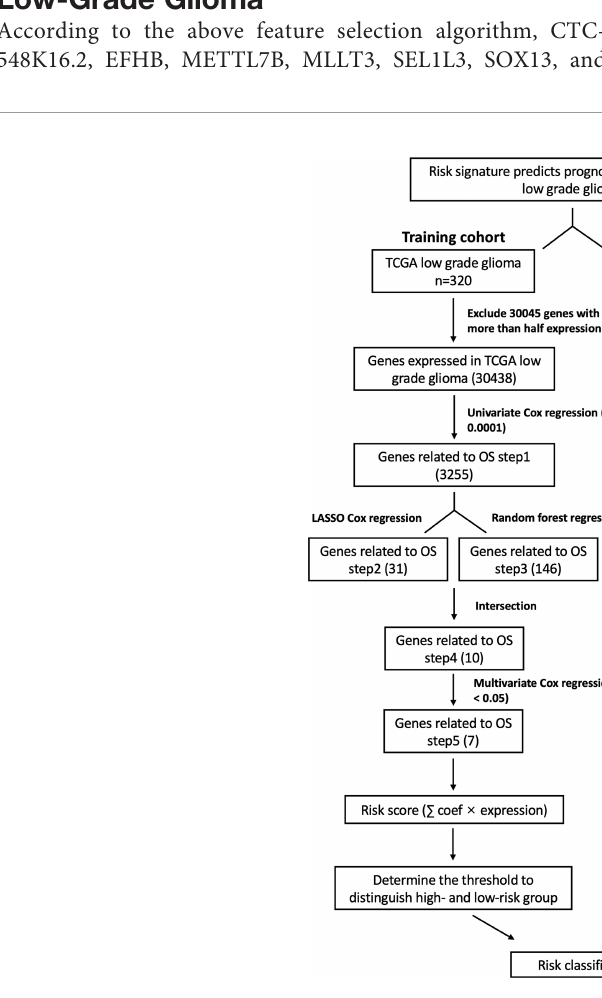
FIGURE 1 | Schematic diagram of a gene screening strategy for prognosis prediction in this